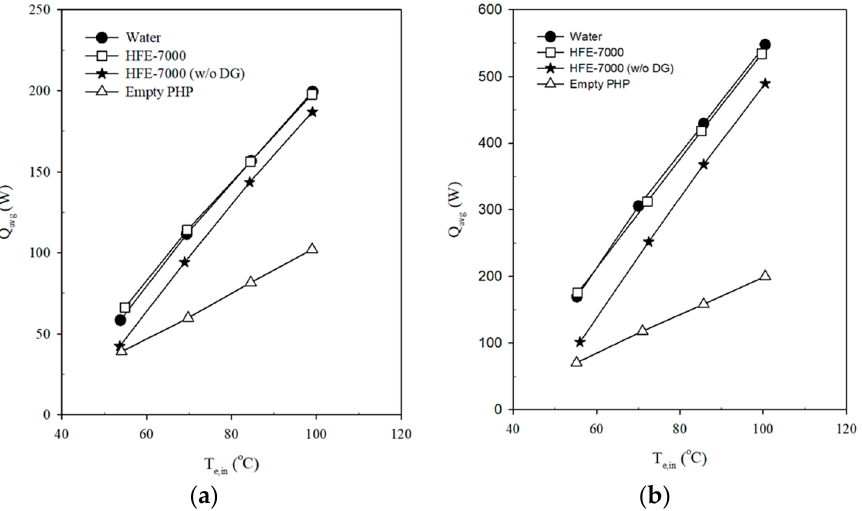
Figure 4. Heat transfer rate of four heat exchangers possessing water-charged PHP, HFE-7000-charged PHP with and without degassing, and empty PHP versus the inlet temperature of the hot air with filling ratio of 35% at air velocity of ( a ) 0.5, and ( b ) 2.0 m/s.